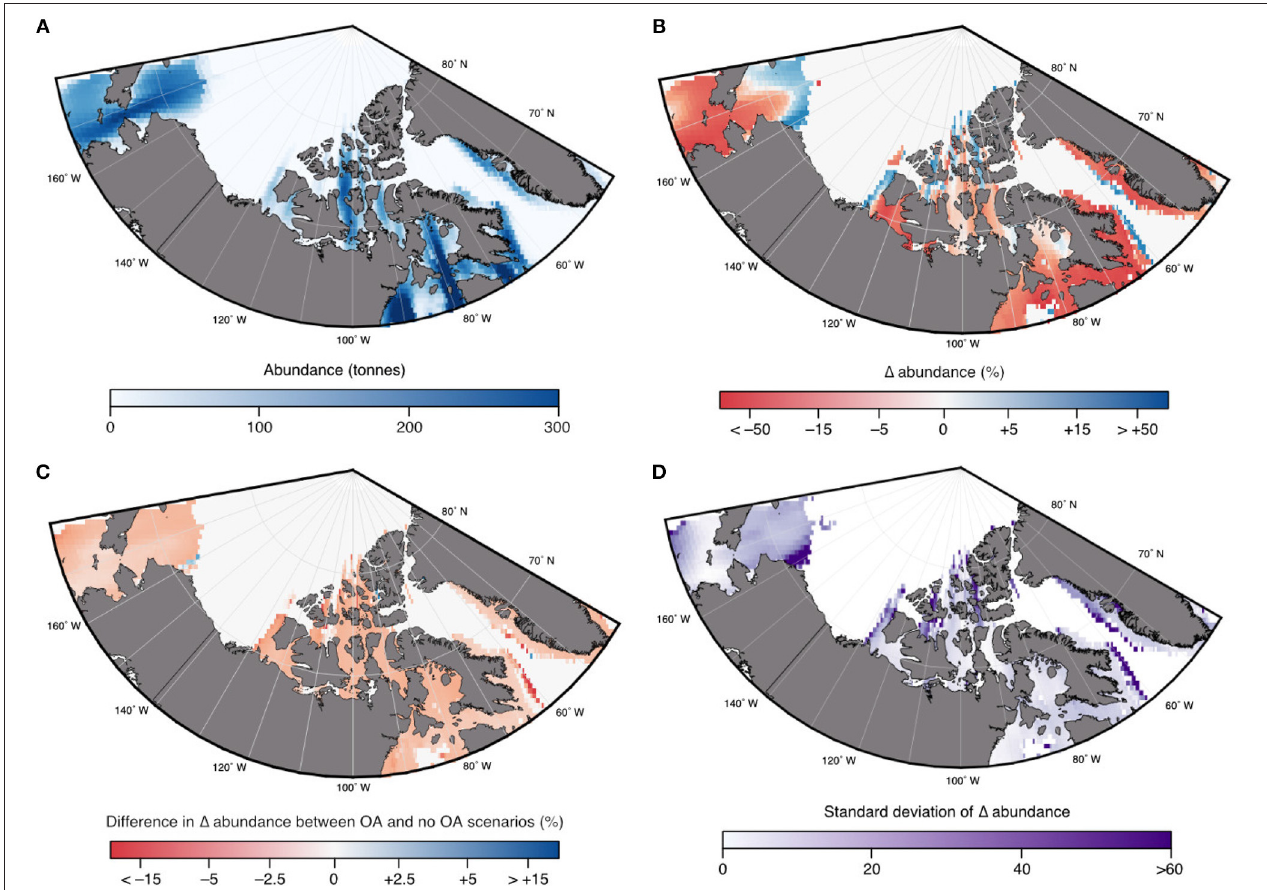
FIGURE 9 | Projected multimodel mean (of the 3 ESMs) changes in abundance for Arctic cod ( B. saida ) under the high emission (RCP8.5) scenario: (A) 2001–2010 abundance; (B) relative changes in abundance by 2100 compared to 2001–2010 in response to multiple stressors (i.e., ocean acidification, temperature, oxygen); and (C) changes in abundance due to additional effects of ocean acidification (OA) using a 20 % negative effect on growth and survival (see text); and (D) the standard deviation of the changes in abundance shown in B, based on the three input ESMs. Modified from AMAP (2018) with permission from AMAP.